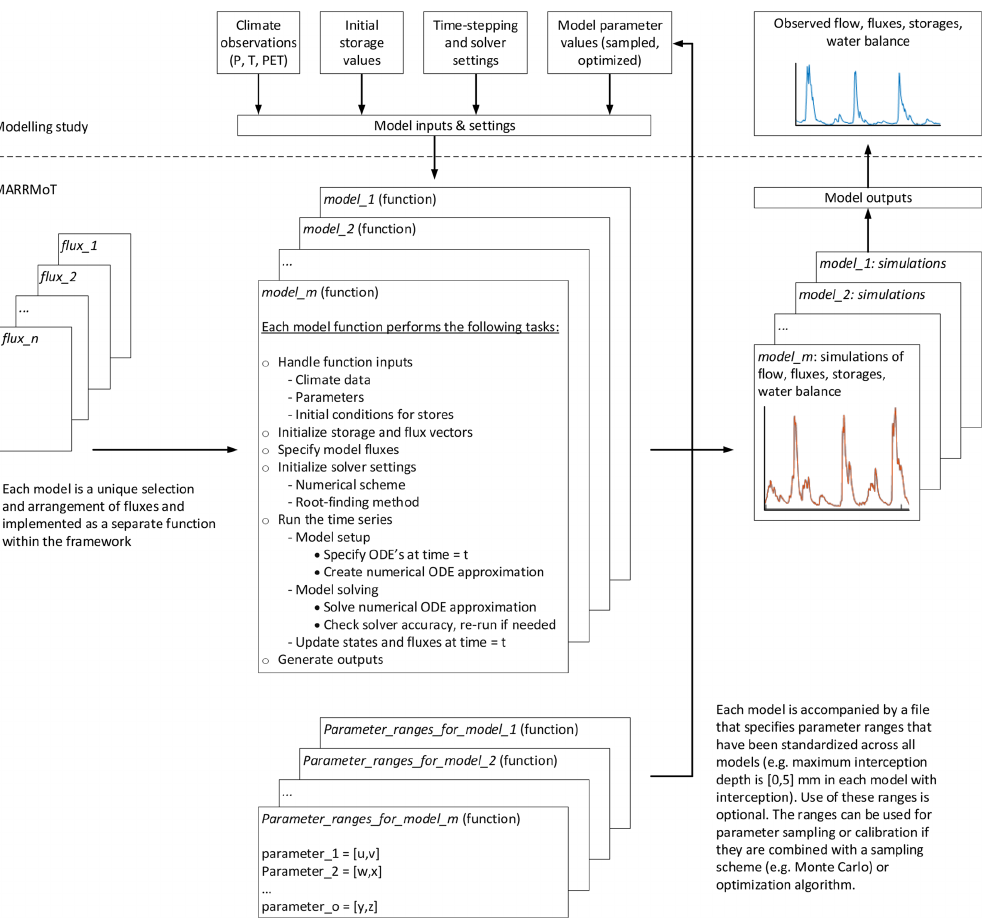
Figure 1. Schematic overview of the MARRMoT framework. MARRMoT provides 46 conceptual models implemented in a standardized way (part below the dotted line). Each model is a unique collection and arrangement of fluxes, but the code-wise setup of each model is the same. Inputs required to run a model are time series of climate variables, values for the model parameters (which can optionally be sampled or optimized using provided, standardized ranges), and initial conditions for each model store. The model returns time series of simulated flow, fluxes, and storages and a summary of the simulated water